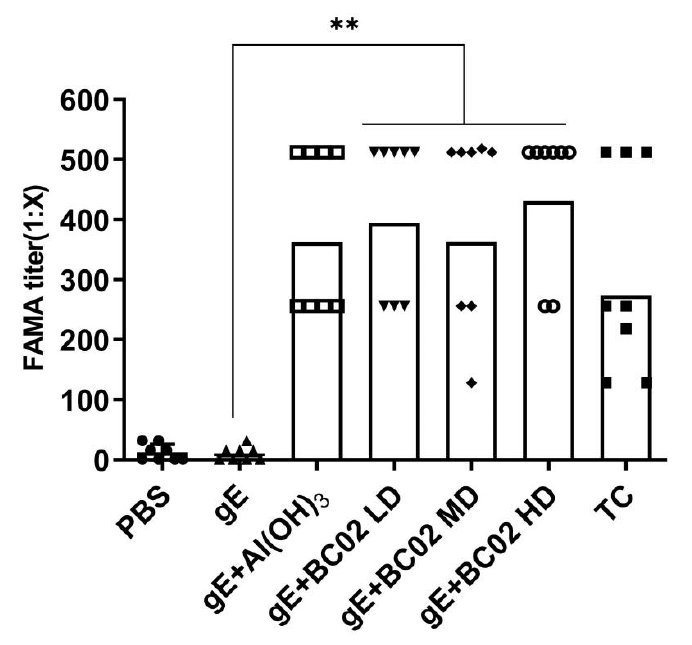
Figure 4. Anti-VZV antibodies induced by BC02-adjuvanted gE experimental vaccine. FAMA serology test to determine susceptibility to VZV infection. Serum from each mouse was diluted at twofold serial dilution (1:2–1:512) to determine the maximum dilution ratio for obtaining the lowest positive fluorescence signal. ** indicates that there is a significant statistical difference between gE + BC02 LD/MD/HD compared with gE, or gE + Al(OH) 3 , respectively, p < 0.05. LD: Low dose, MD: Medium dose, HD: High dose.